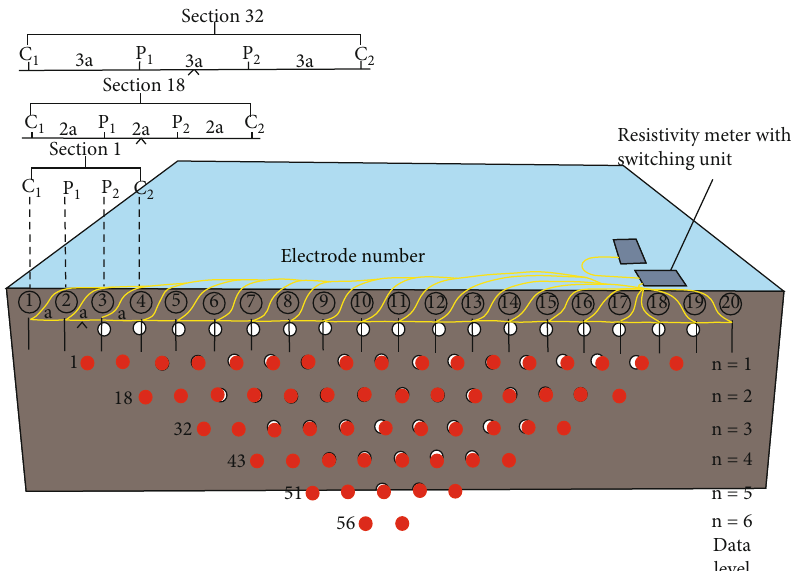
Figure 7: Schematic diagram of the high-density resistivity method.